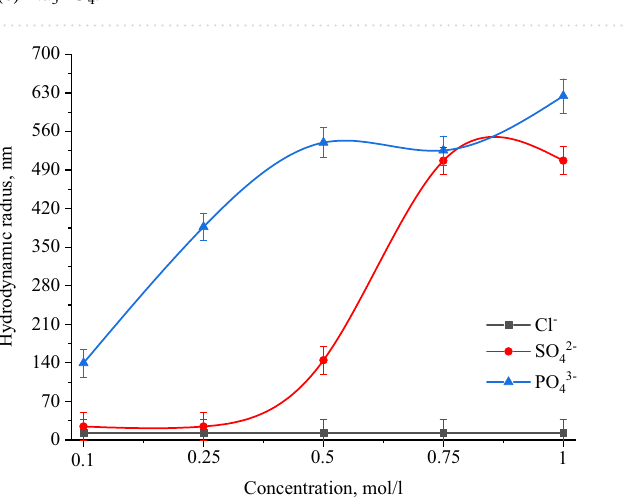
Figure 9. The coagulating effect of salts on the positive Se NPs sol: ( a ) NaCl; ( b ) BaCl 2 ; ( c ) FeCl 3 ; ( d ) Na 2 SO 4 ; ( e ) Na